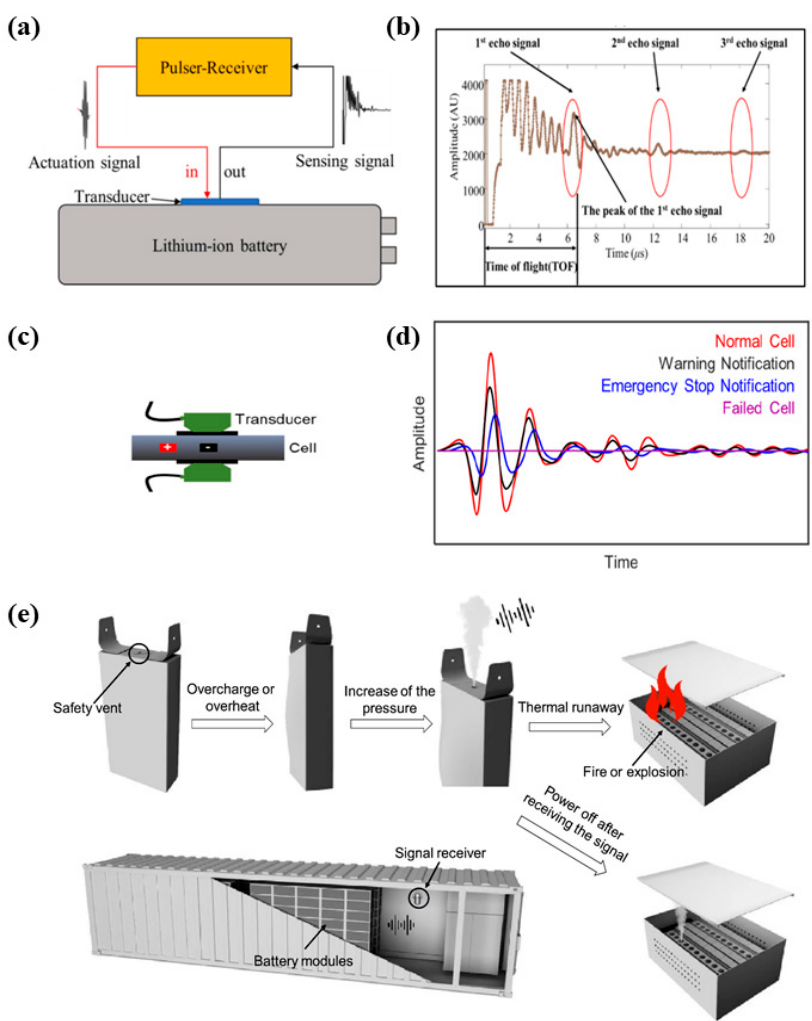
Figure 2. Acoustic safety monitoring method: ( a ) pulse-echo mode [54]; ( b ) propagation time of ultrasonic signal inside the battery [55]; ( c ) through-transmission mode [54]; ( d ) ultrasonic amplitude change [57]; ( e ) acoustic signal to warn the TR [32].